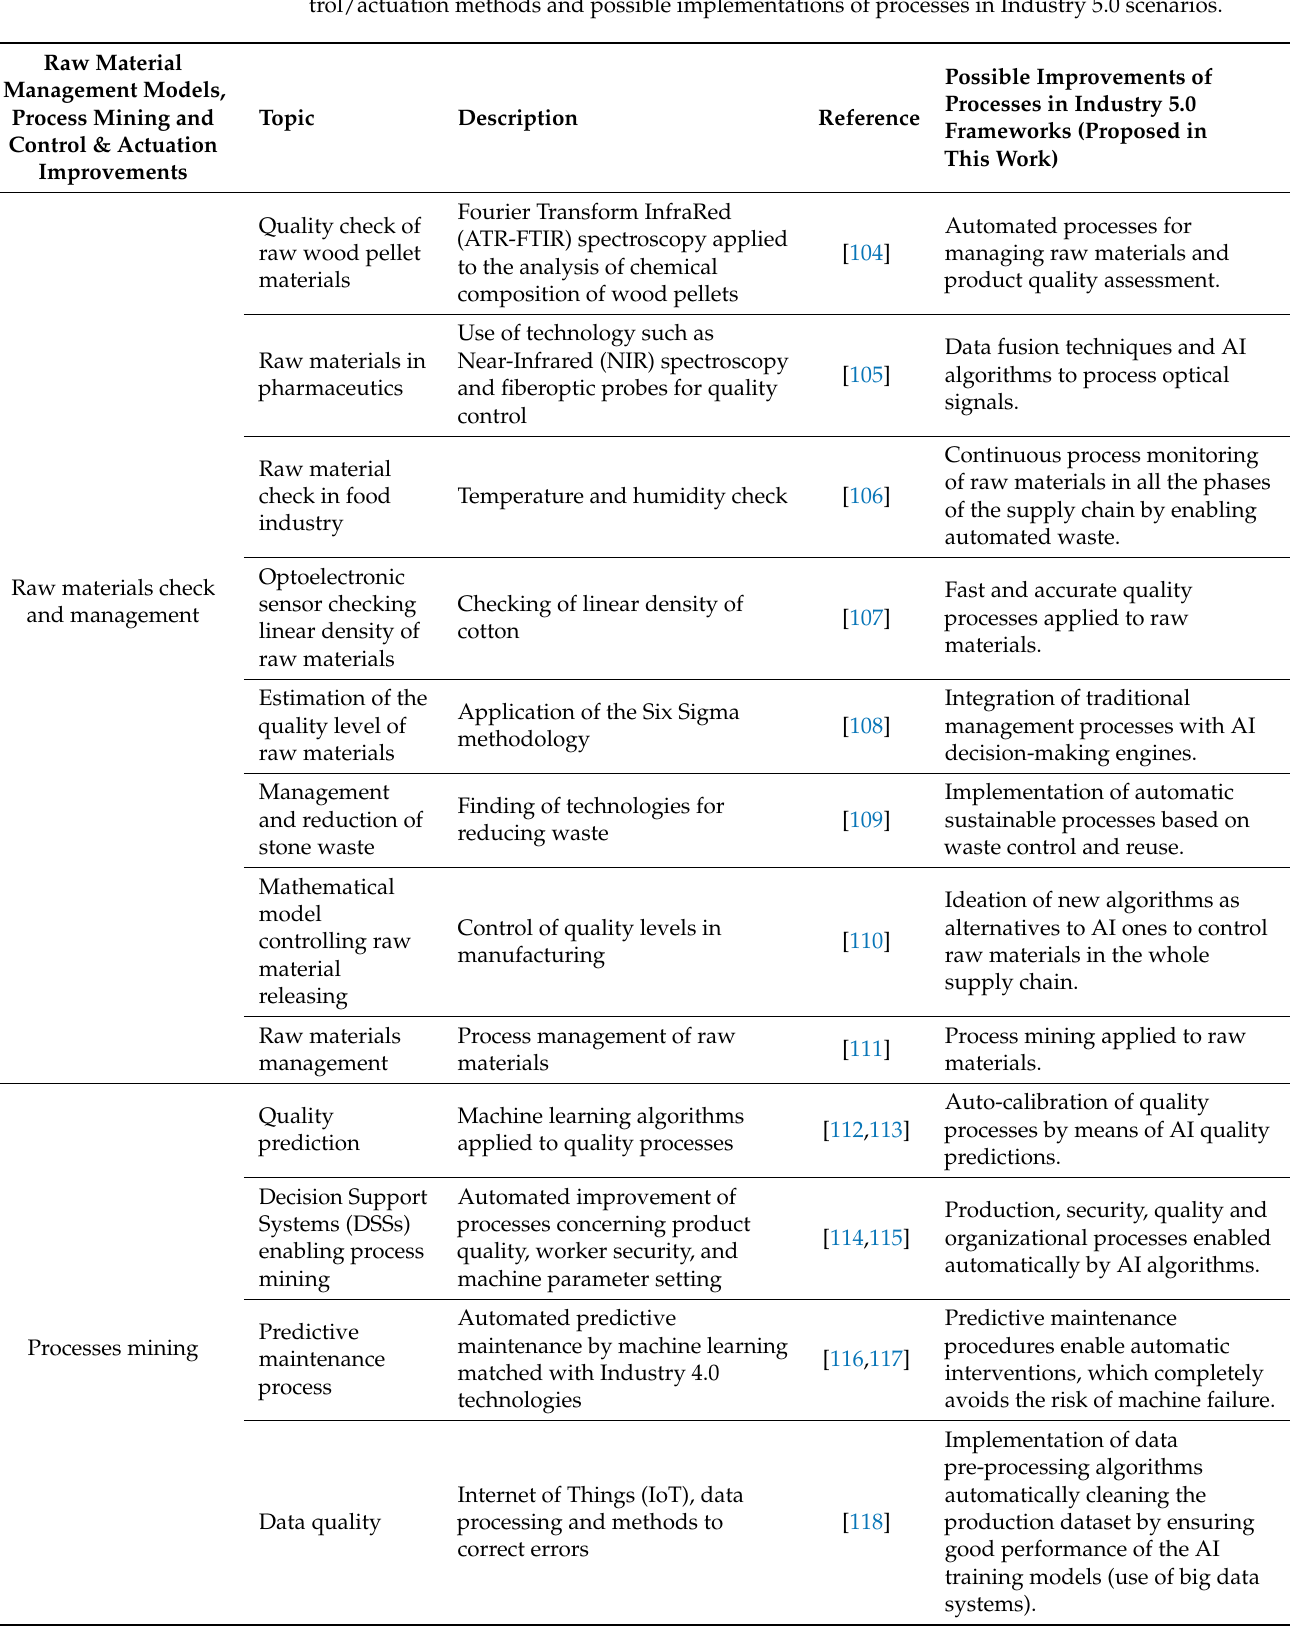
Table 4. State of the art: raw materials management advanced approaches, process mining, con- trol/actuation methods and possible implementations of processes in Industry 5.0